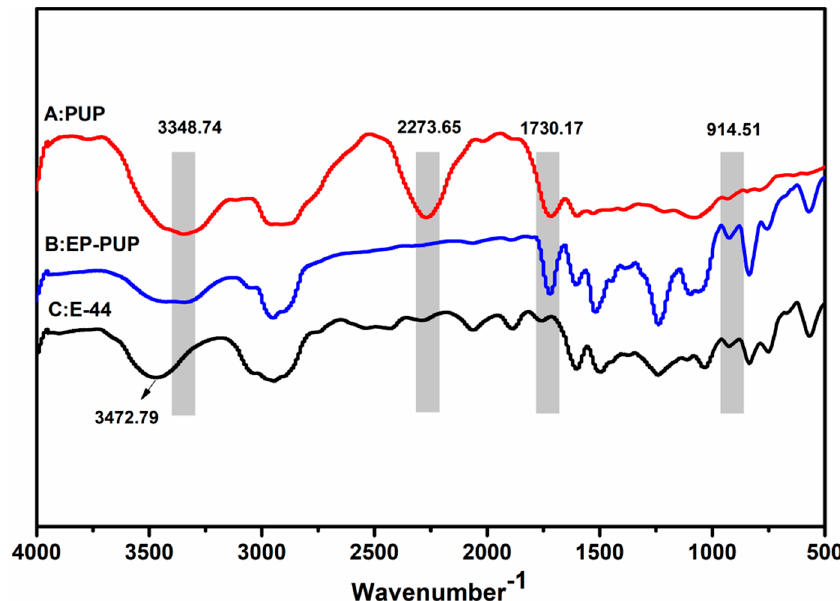
Figure 5. FTIR spectra of the polyurethane prepolymer (A), modified epoxy (B), and neat epoxy E-44 (C).